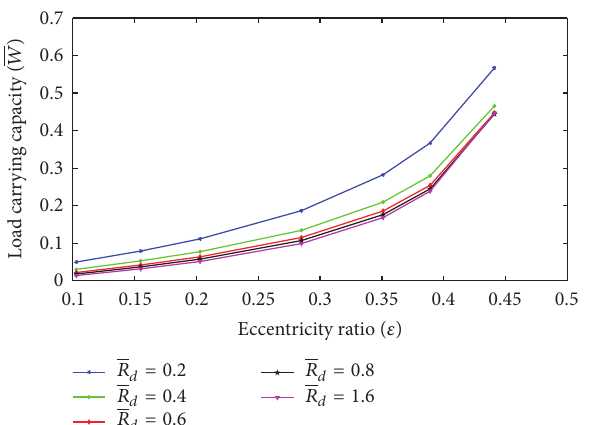
Figure 5: Effect of relief track depth ratio on flow coefficient.